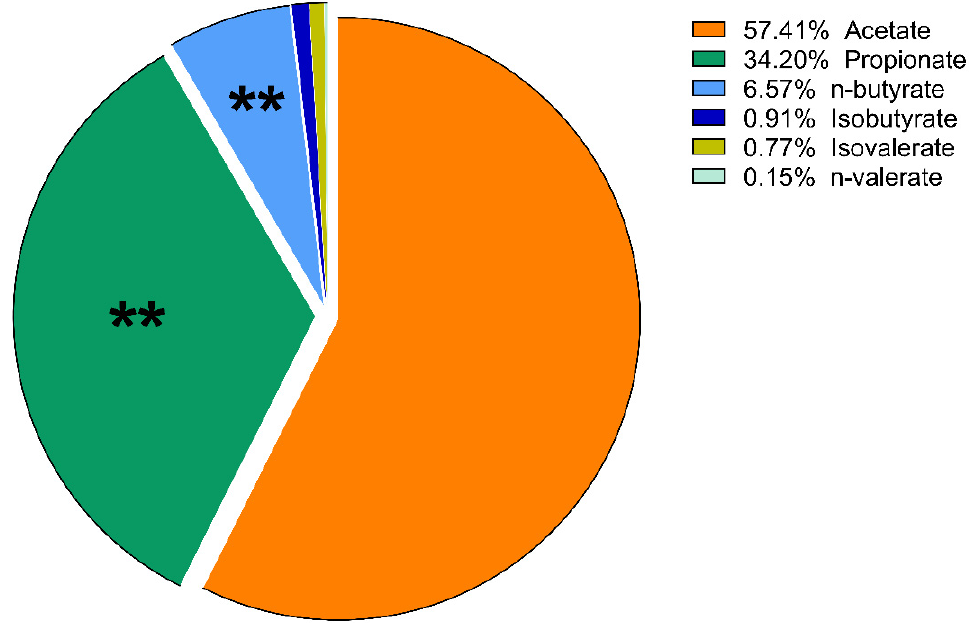
Figure 7. Volatile fatty acid profile of fecal samples of the lactulose group on day 10 of the experiment measured by GC-MS method. Data are expressed as mol%. ** p < 0.01.